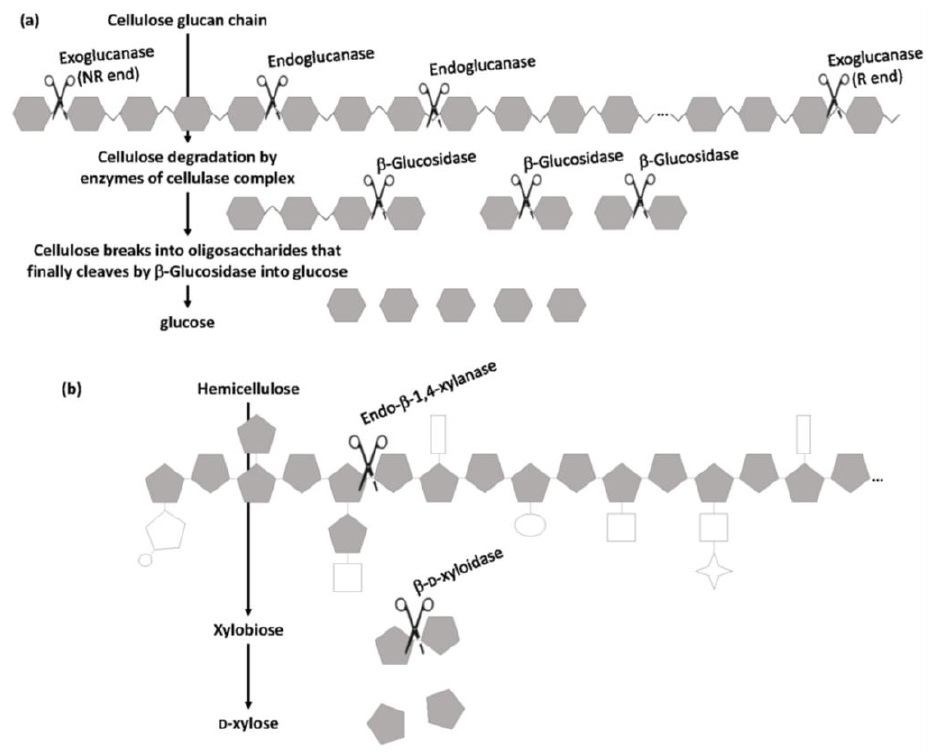
Figure 8. Enzymatic hydrolysis mechanism on cellulose ( a ) and hemicellulose ( b ) (reproduced from [45], published under CCBY 4.0 license).